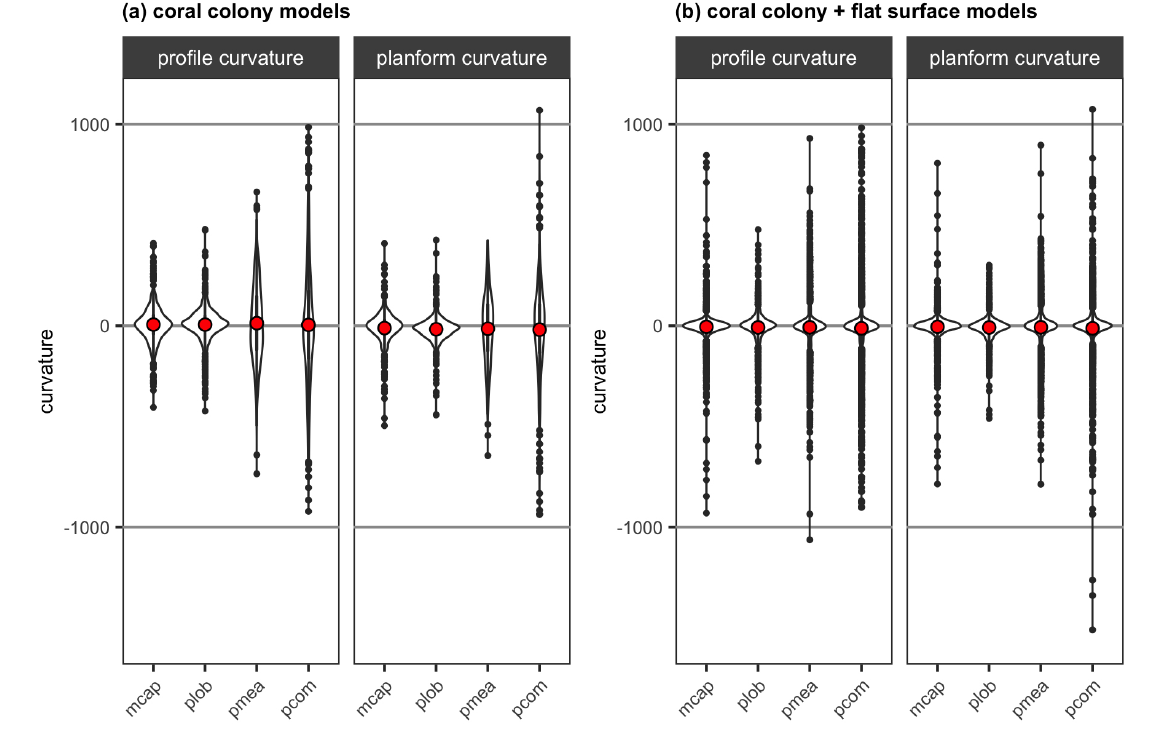
Figure 13. Violin plots for profile curvature and planform curvature extracted from the DEMs of ( a ) the four reconstructed coral colonies with different morphologies and ( b ) the four reconstructed coral colonies with different morphologies with a substratum: mcap = encrusting M. capitata , plob = mounding P. lobata , pmea = branching P. meandrina and pcom = branching P. compressa . The mean value of curvature for each colony is shown as red